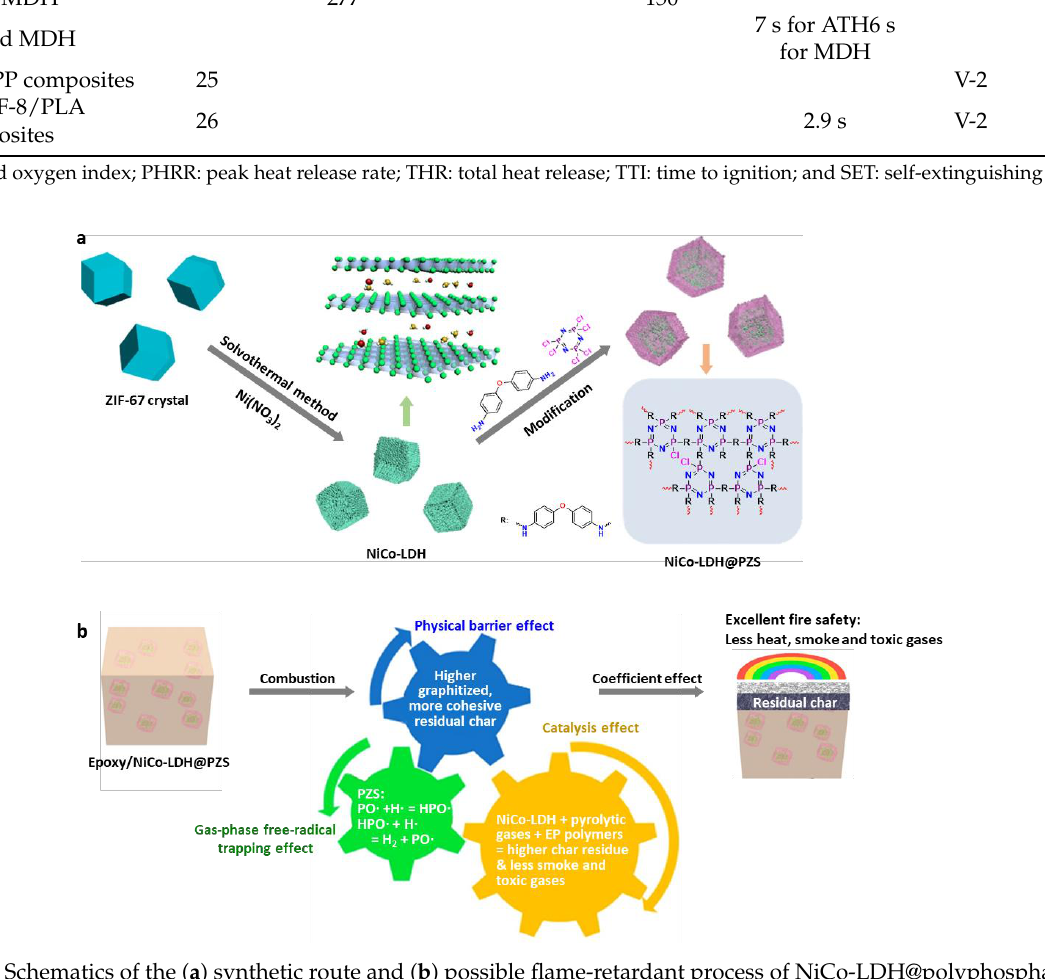
Figure 40. Schematics of the ( a ) synthetic route and ( b ) possible flame-retardant process of NiCo-LDH@polyphosphazene. Reprinted with permission from Ref. [164]. Copyright 2019, ACS.